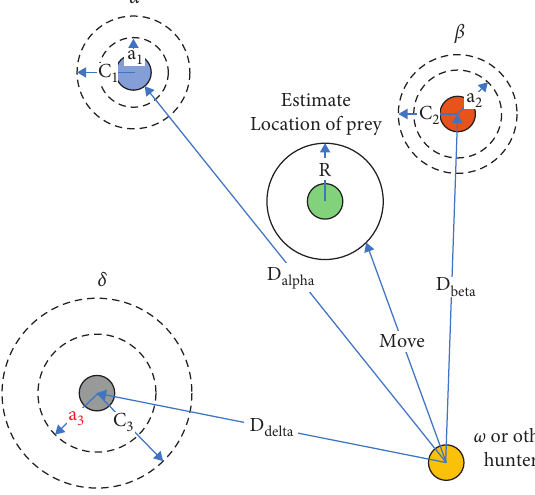
Figure 3: Update rule of grey wolf optimizer